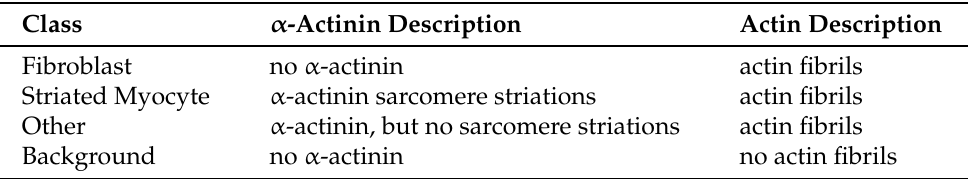
Table 1. Description of semantic classes.